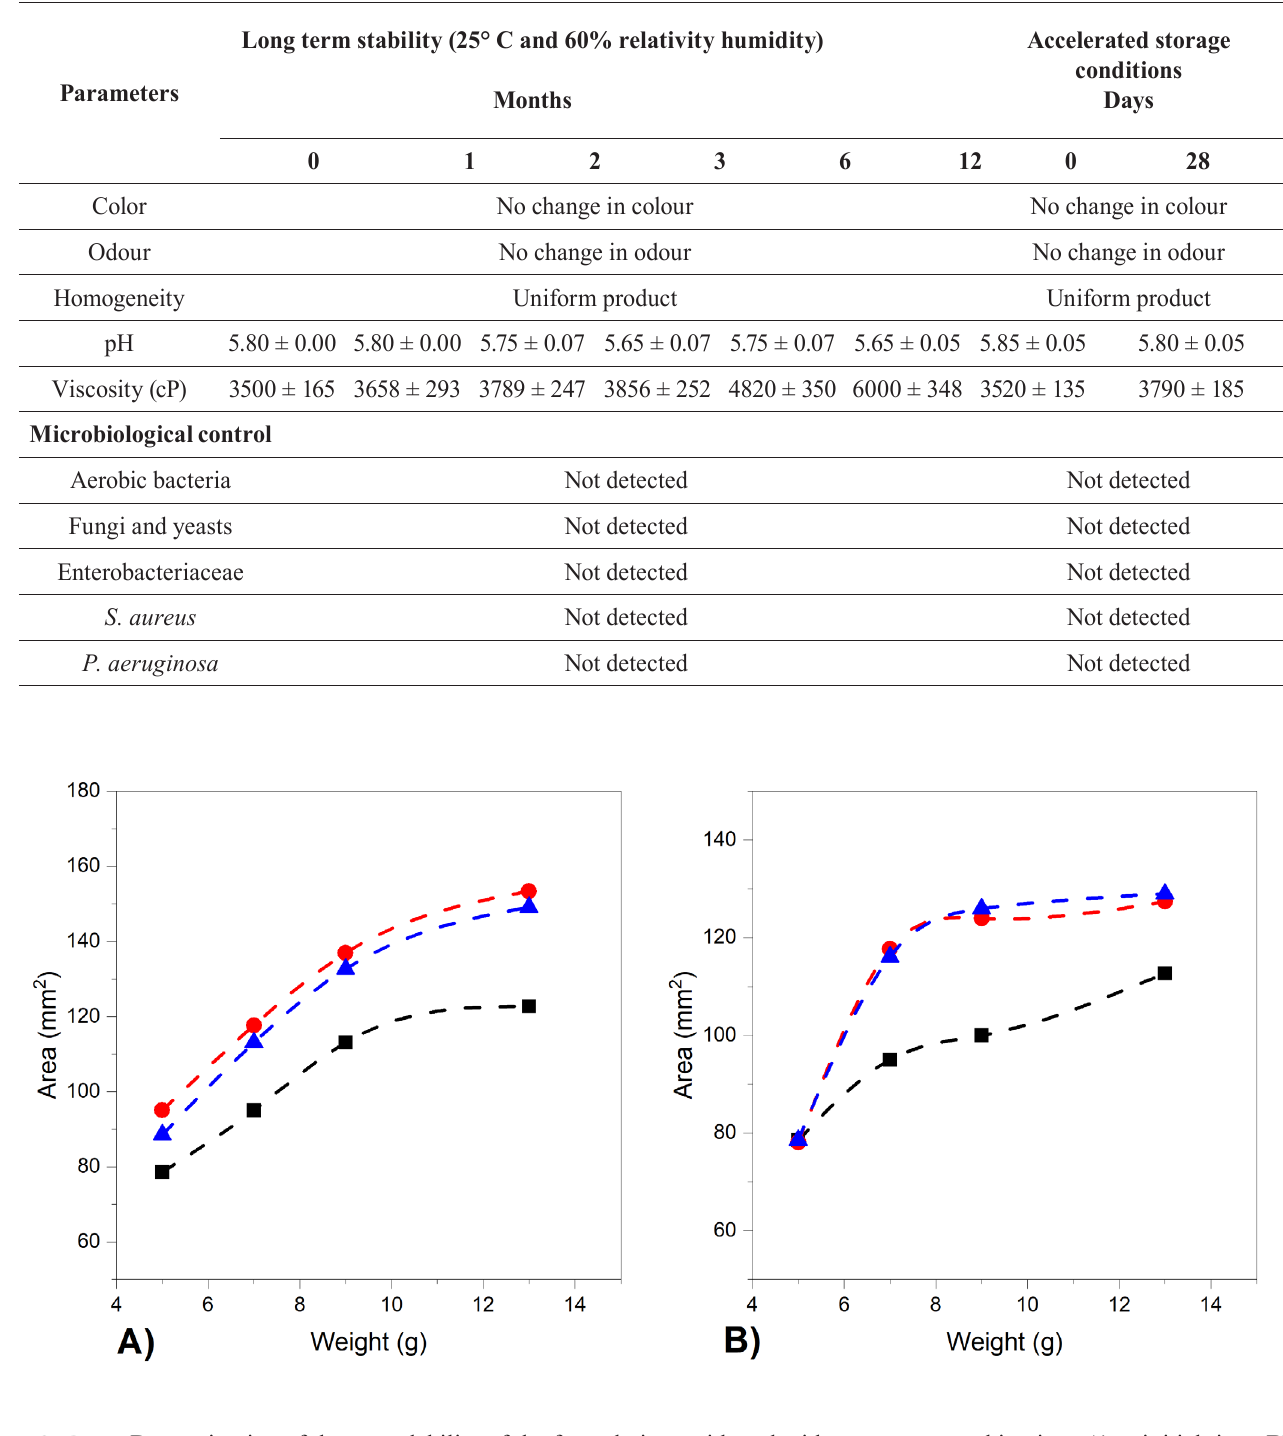
FIGURE 1 - Determination of the spreadability of the formulations with and without extract combinations A) at initial time, B) at 12 months. Formula base (■), Gel samples with combination of extracts stored on shelf (▲), Gel samples with combination of extracts for daily use